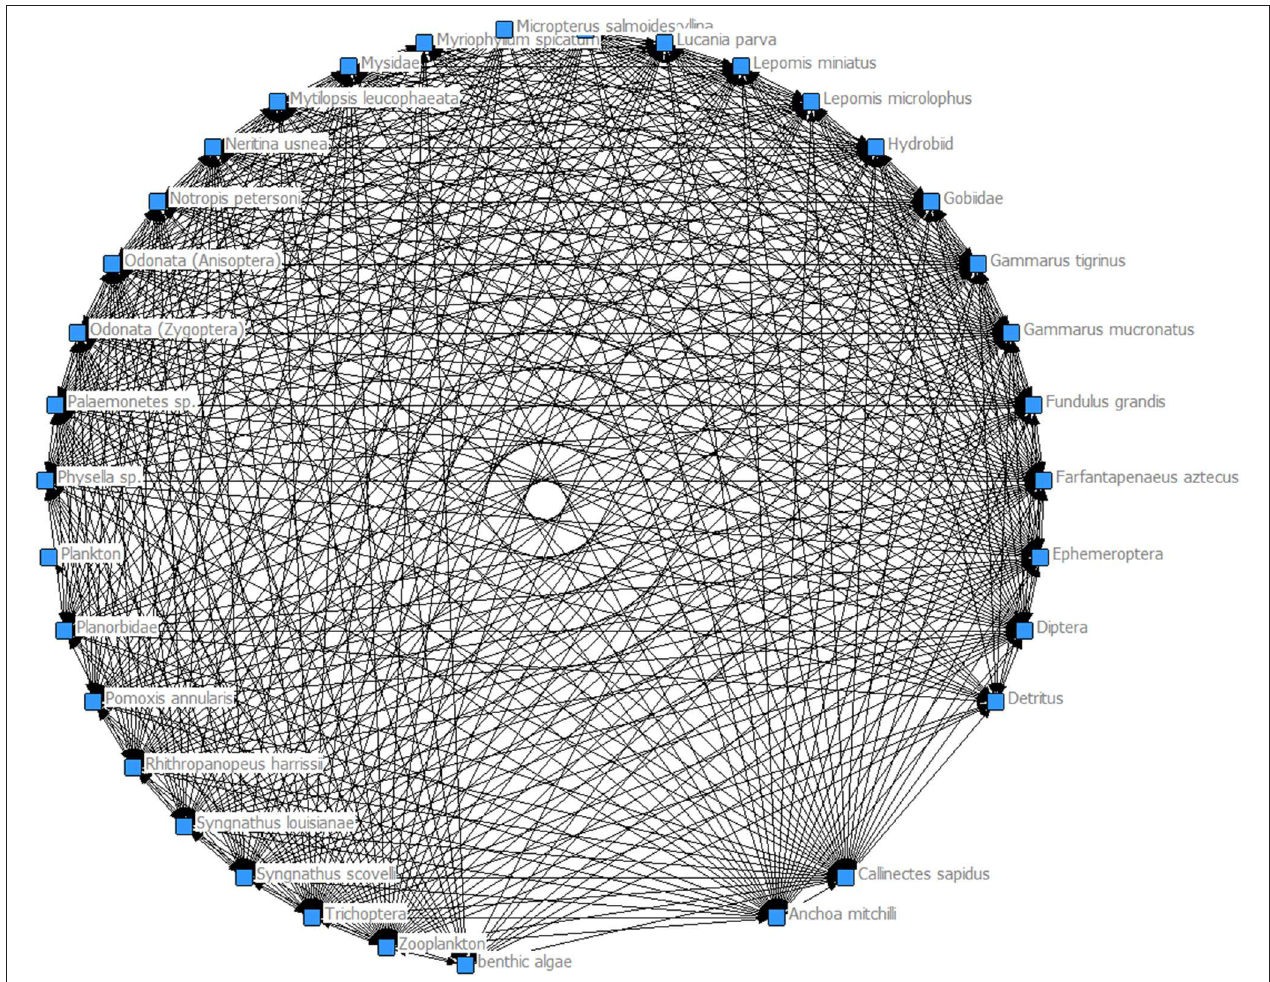
FIGURE 2 | Network model using existing data for Myriophyllum spicatum